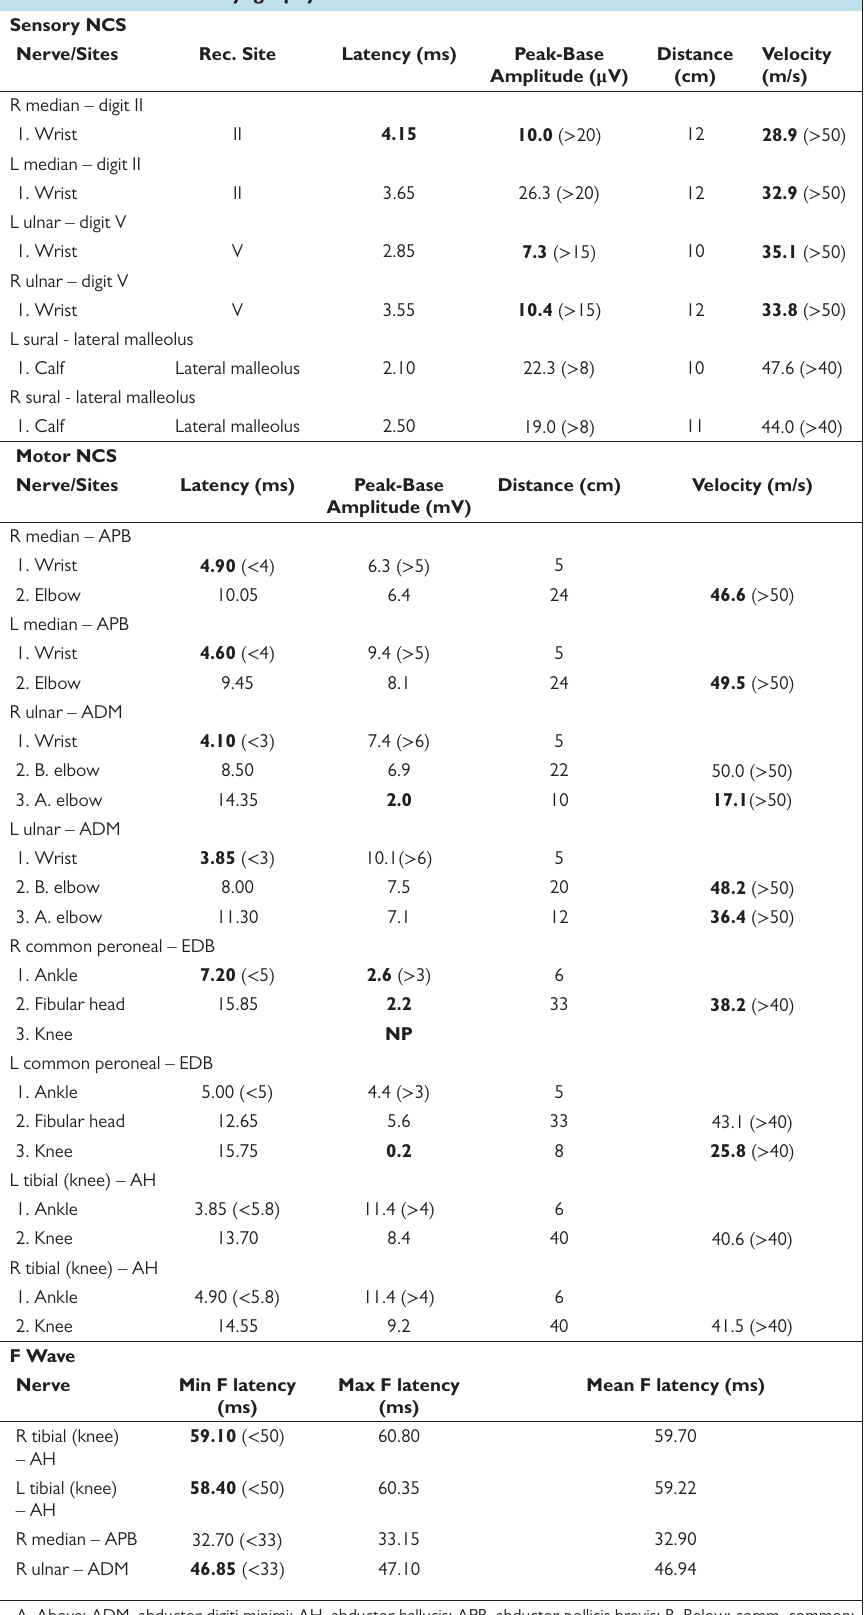
Table 1. Electroneuromyography Sensory NCS